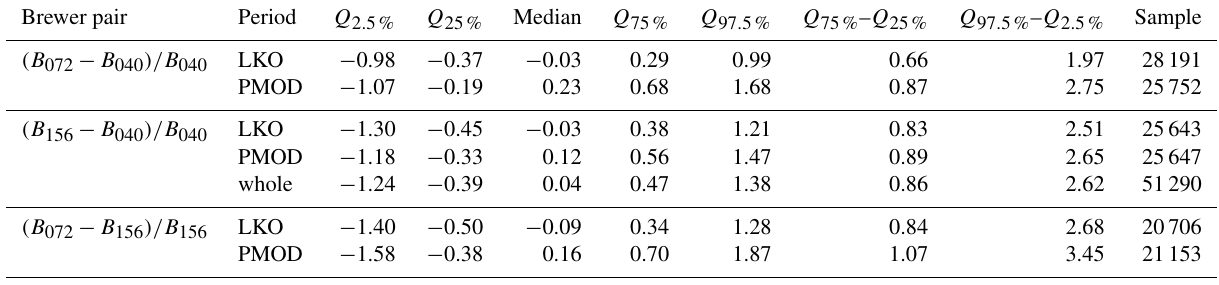
Table 2. Quantiles of the distributions of the differences expressed in [%] between pairs of Brewer instruments collocated at Arosa (period LKO) or with B 072 at PMOD/WRC (period PMOD).